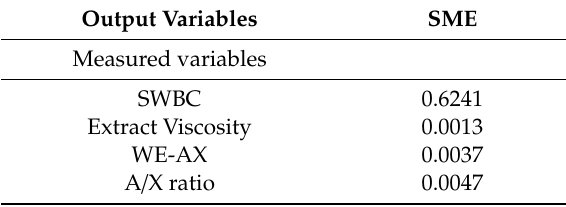
Figure 4. Scatterplot of ( A ) strong water-binding capacity of extruded wheat bran samples according to screw configuration used during processing. Data points are coloured according to last-barrel set temperature and ( B ) ( left ) extract viscosity according to screw configuration and ( right ) according to specific mechanical energy (SME). Data points are coloured according to moisture content during extrusion-cooking The triangles represent the median obtained by configuration. Table 3. p -value table of the linear model describing the e ff ect of specific mechanical energy (SME) on the measured variables (strong water-binding capacity (SWBC), extract viscosity, water-extractable arabinoxylan (WE-AX) content and arabinose to xylose (A / X) ratio). The model was built for each output variables (Y) using the following equation: Y = α + β × SME. The output variable is determined by SME if the p -value is smaller than 0.05 (significance